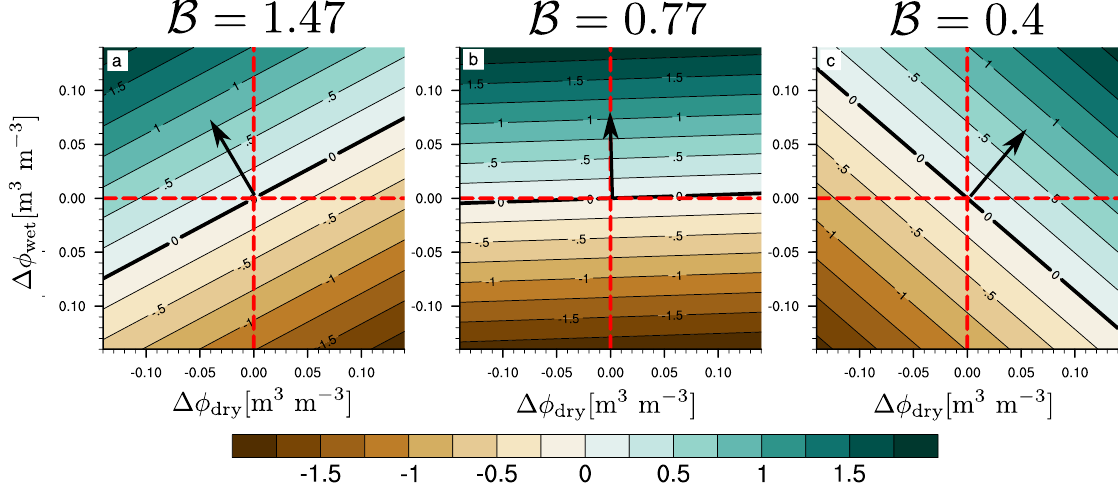
Figure 11. (cid:49)P dry as a function of (cid:49)φ dry and (cid:49)φ wet for different values of the parameter B . The x and y axes represent the variation in φ dry and φ wet , respectively. Note that the maximum variation is φ crit − φ wp , as (cid:49)P dry is computed for the regime φ wp <φ dry , wet <φ crit . The red dashed lines indicate no variation in the soil moisture of either one of the patches. The efficiencies are set to ( η A , η E ) = (0.16, 0.11) in (a) and to ( η A , η E ) = (0.47, 0.35) in (b) and (c) to match the simulation results. The black arrows indicate the direction of maximum growth, i.e., when an increase in precipitation is